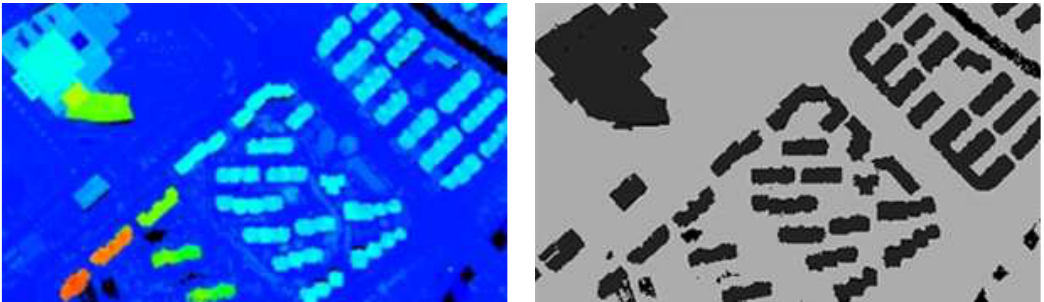
Figure 3. LDR 1 elevation coloration and manual extraction results.